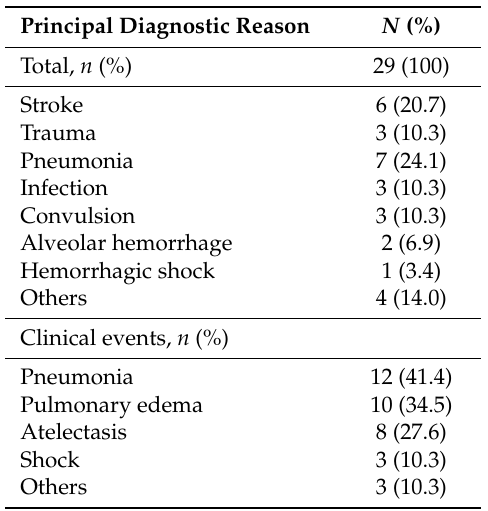
Table 3. Principal diagnostic reasons for tracheal intubation and clinical events occurring in the VAE